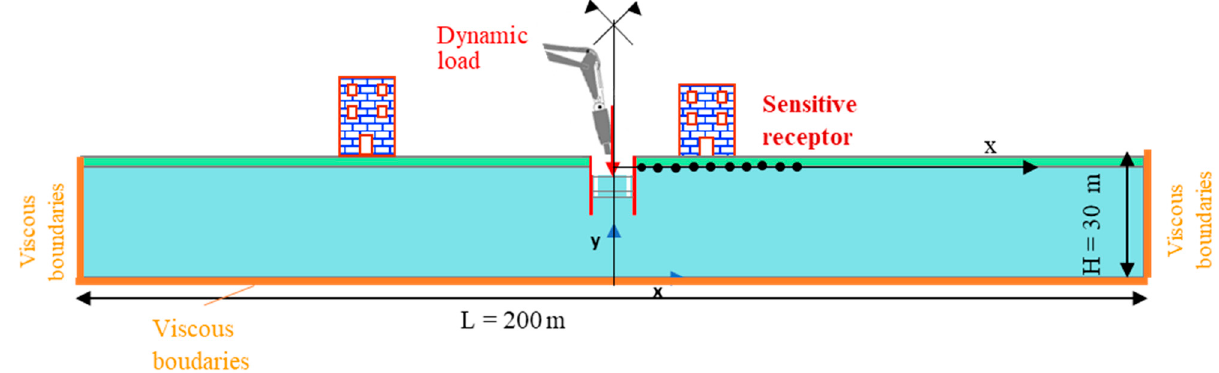
Figure 2. Numerical model of the rock excavation process.